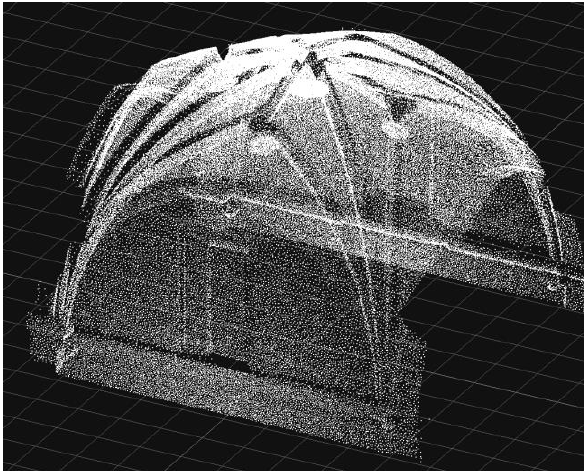
Figure 3. 3D point cloud of the stellar